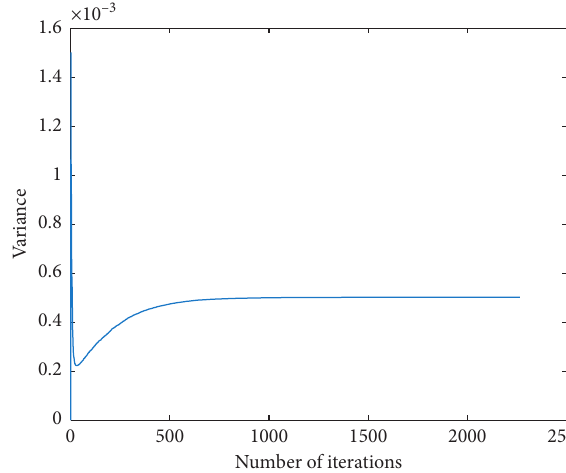
Figure 4: Convergence behavior of Nadam algorithm.